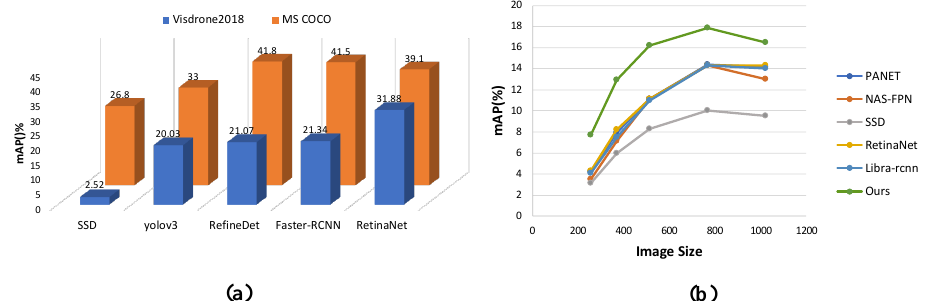
Figure 1. Difference comparison. ( a ) The accuracy gap between some state-of-the-art (SOTA) de- tectors on MSCOCO and Visdrone2018 datasets, including SSD [14], YOLOv3 [15], RefineDet [15], Faster-RCNN [16], and RetinaNet [17], the accuracy data on Visdrone2018 is obtained from [10]. ( b ) The accuracy changes with image size changes of some feature pramid based object detection networks [14,17–20] and our